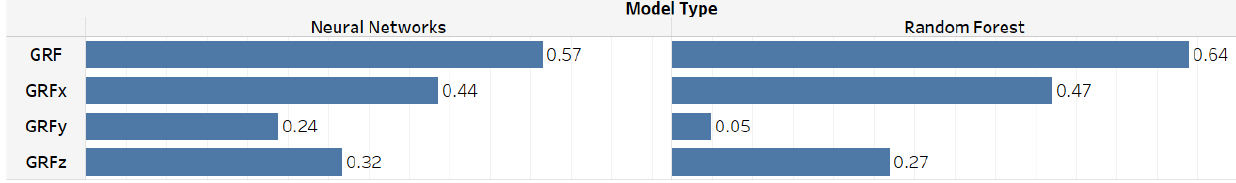
Figure 8. A comparison between GRF-based signals in identifying PAD using Matthew’s Correlation Coefficient as a performance metric. For both Neural Network and Random Forest model approaches, including all GRF components led to better PAD classification compared with any single GRF component (x = anteroposterior, y = mediolateral, and z = vertical).